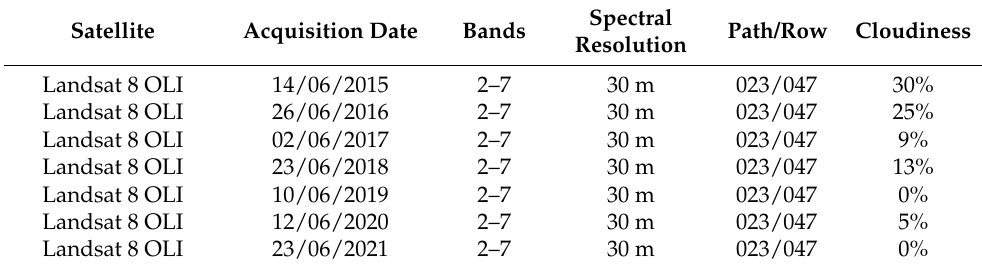
Table 1. Images of Landsat 8 OLI used in the present